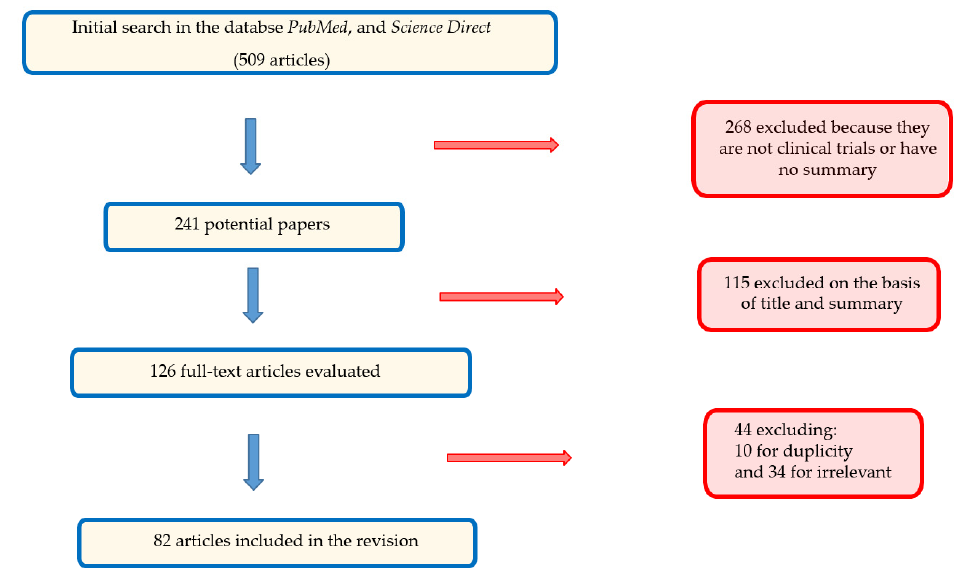
Figure 1. PRISMA flow chart for literature search and selection of articles included in the literature review Pandemic of Childhood Myopia. Could new indoor LED lighting be part of the solution?